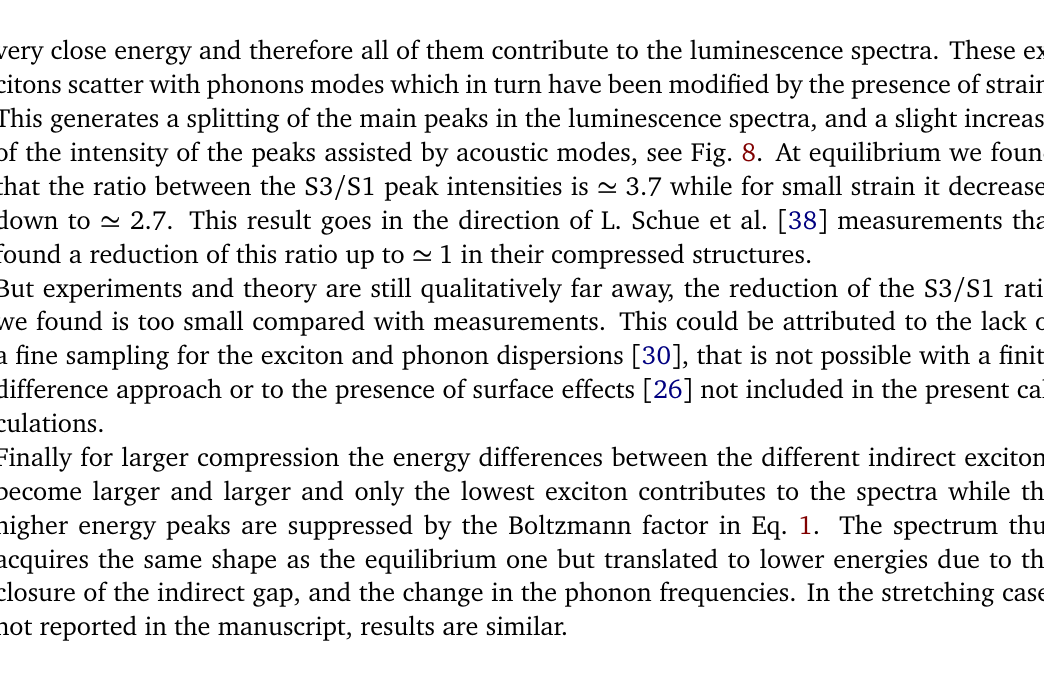
exciton at equilibrium, and 1